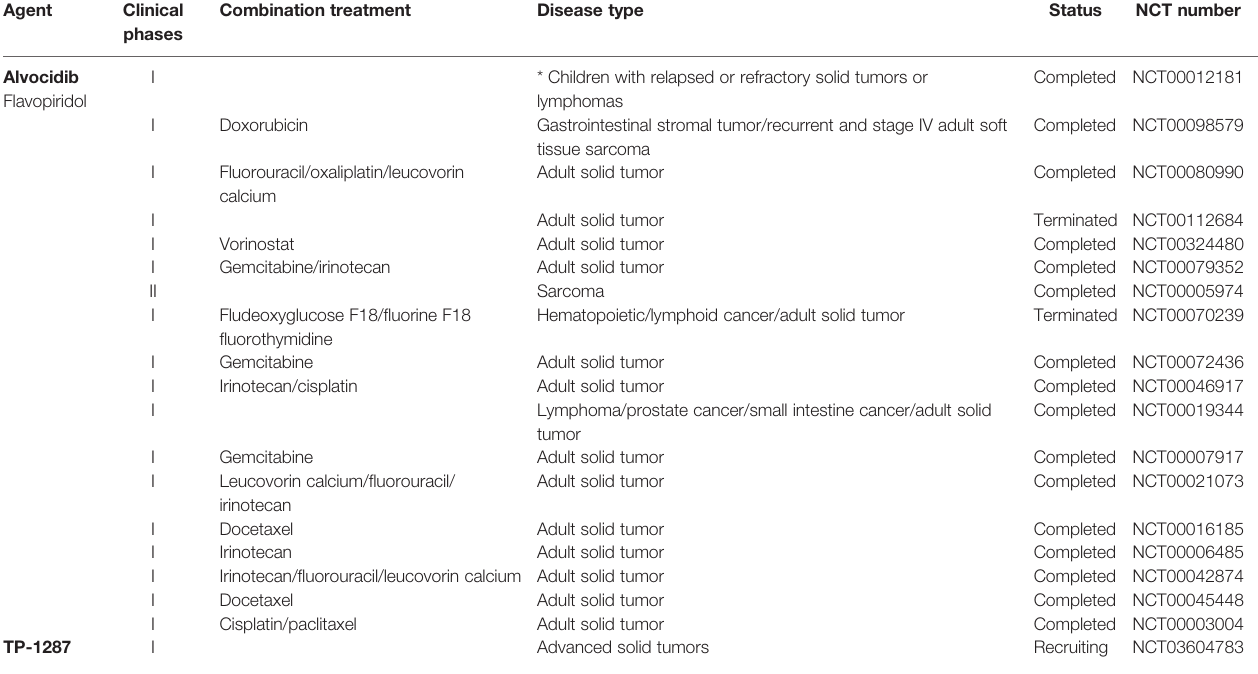
TABLE 1 | Clinical trials of natural products targeting CDK9 used as single agents or in combination in solid tumor including